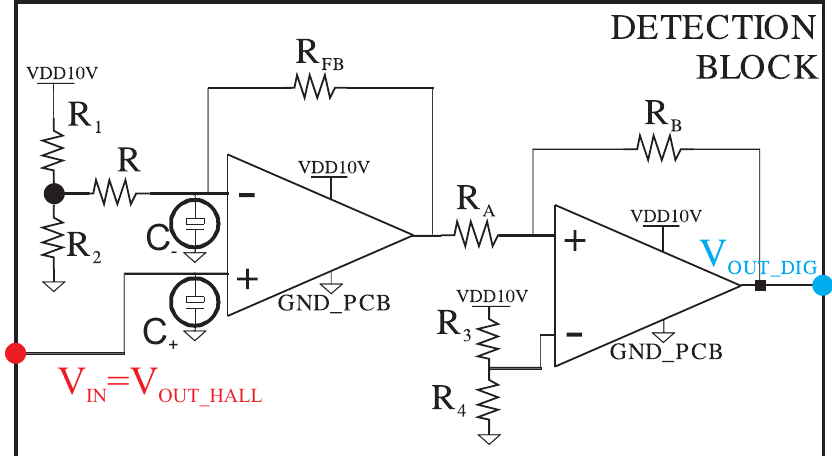
Figure 3. Processing chain of the Hall sensor output voltage.